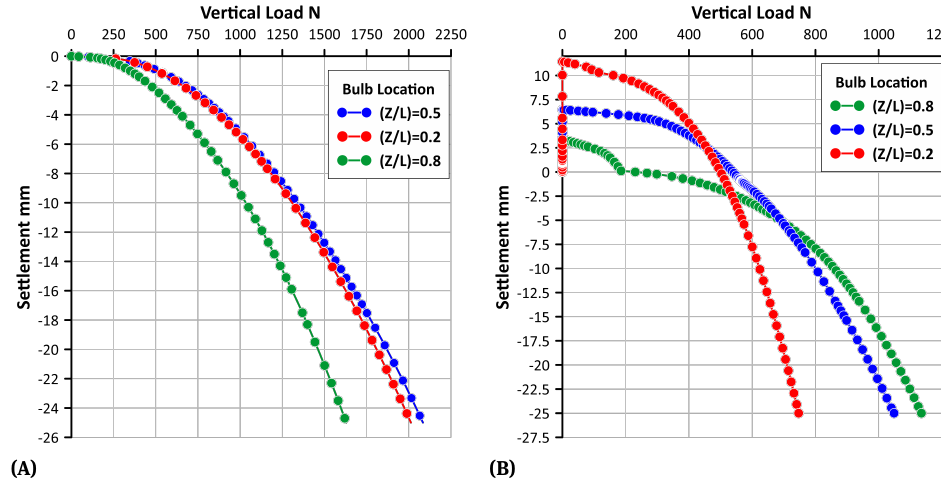
Figure 5: The relation between settlement and axial load for single bulb under-reamed piles (A) Unsaturated soil (B)Saturated soil